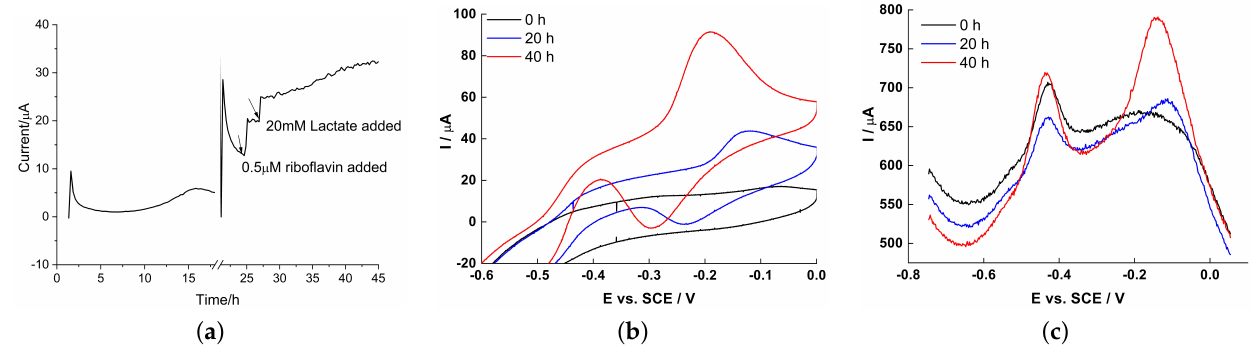
Figure 5. ( a ) CA at 0.24 V, ( b ) CV and ( c ) DPV of early S. loihica PV-4 biofilm grown on